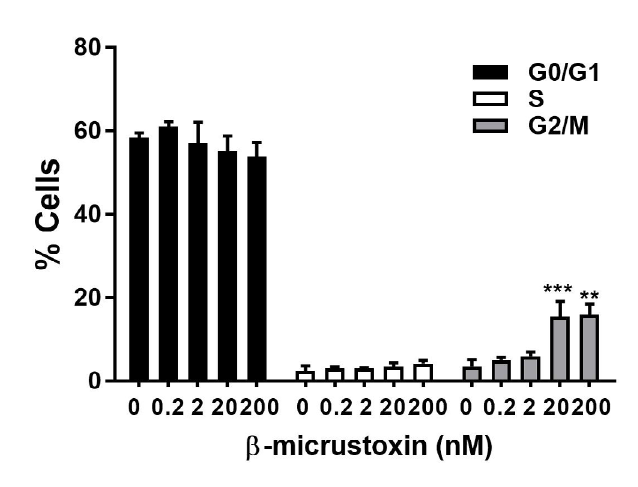
Figure 6. Distribution of cell cycle phases of cultured astrocytes incubated in the absence (control) or presence of β-micrustoxin (0.2, 2, 20, 200 nM) for 24 h. Phases G0/G1, S-synthesis, G2/M are expressed as a percentage. Two-way ANOVA; Bonferroni post-hoc test: **p < 0.01; ***p < 0.001 vs. control, N = 4/group.